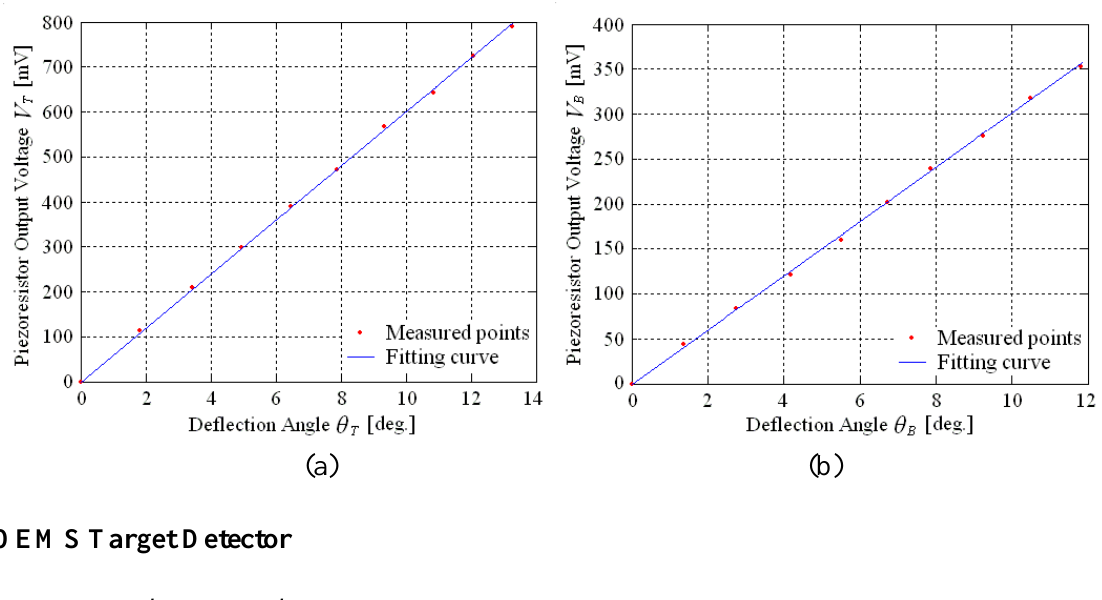
Figure 10. Piezoresistor output characteristics in two directions. (a) deflection angle measurement in twisting direction, (b) deflection angle measurement in bending